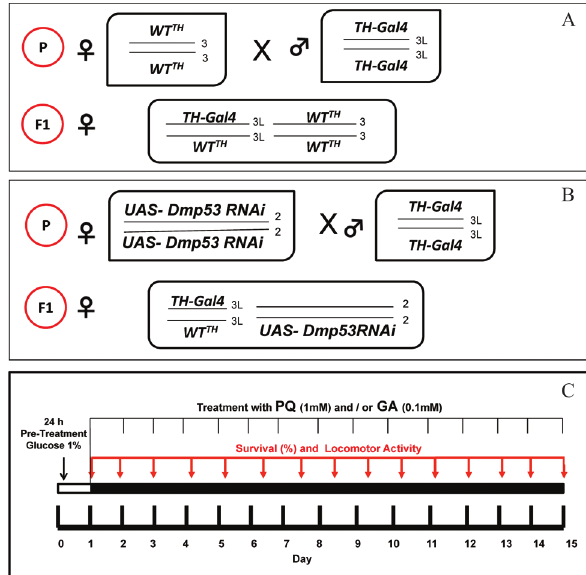
Figure 1 - Scheme for basic fly cross and selection. (A) TH-Gal4 +/- flies were obtained by crossing TH-Gal4 +/+ (males, n = 10) and wild type Can- ton S Drosophila melanogaster (females, n = 10). After five days of hus- bandry, parental flies were discarded from the mating tubes. F1 flies were then reared according to standard procedures. (B) TH-Gal4 +/- , UAS-X RNAi +/- flies, where X represent either Dmp53 , basket or drICE gene, were obtained by crossing TH-Gal4 +/+ (males, n = 10) and UAS-X RNAi +/+ (fe- males, n = 10). For the sake of clarity, TH-Gal4 +/- UAS-Dmp53 RNAi +/- transgenic is shown as representative sample. (C) Schematic representa- tion of feeding schedule, paraquat (PQ), and/or polyphenol (gallic acid, GA) treatments in Drosophila melanogaster